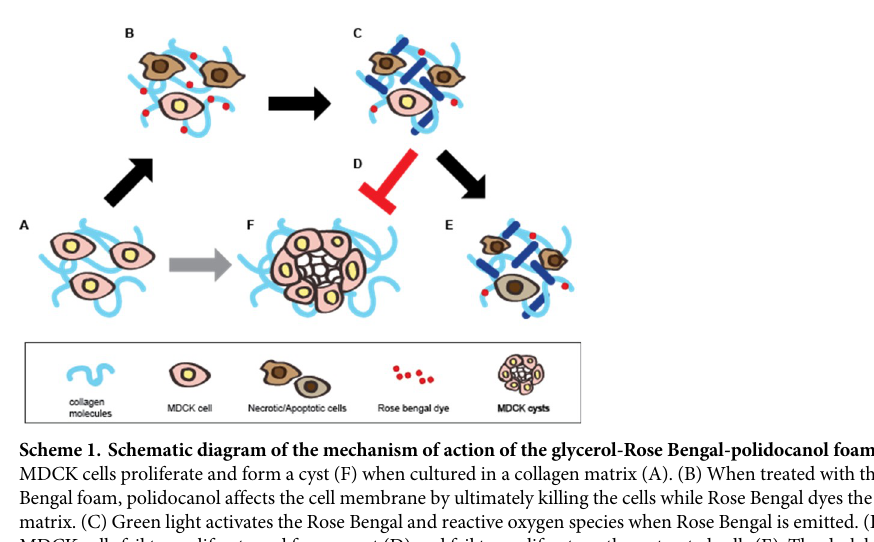
S1 Fig. Policodanol-glycerol-foam is not as cytotoxic to T3TL1 cells as to MDCK cells. (DOCX) S2 Fig. Rose Bengal does not alter cytotoxicity of the polidcoanol-glycerol-rb-foam. (DOCX) S3 Fig. Rose Bengal delivered by foam is activated by 532nm laser irradiation and cause ROS generation. (Scale bar = 50 μ m).